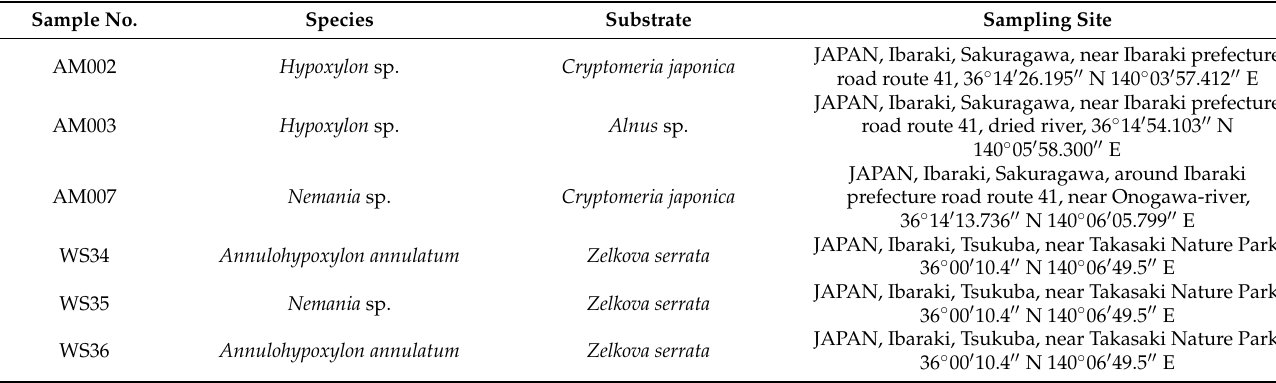
Table 1. List of samples from the moist forest (Sakuragawa area) and the urban dry forest (Tsukuba area). Sample